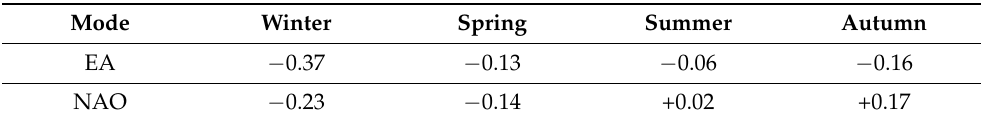
Table 1. Median of the circulation indices EA and NAO for each season of the year during the period 1950–2019. Mode